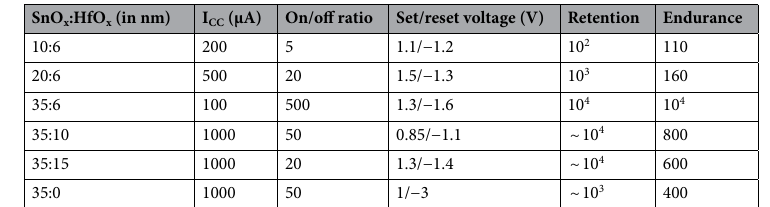
Table 2. Comparison of different resistive switching parameters at various thicknesses of SnOx and HfO x layers of ITO/SnO x /HfO x /ITO/PEN